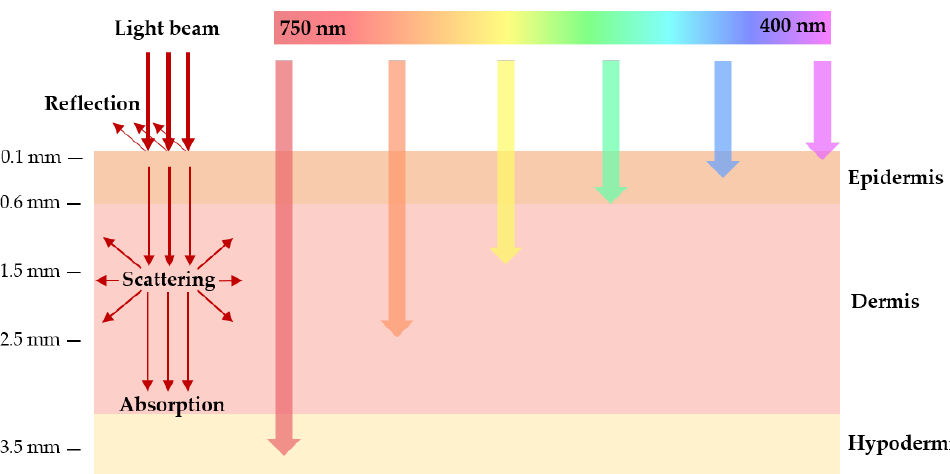
Figure 3. Schematic representation of wavelength-dependent light penetration into biological tissue. The schematic shows a section of the skin layers (epidermis, dermis, and subcutaneous layer). The arrows represent the penetration power of light with different wavelengths in the tissues. Blue light penetrates less efficiently into the tissue, while red light penetrates more deeply.